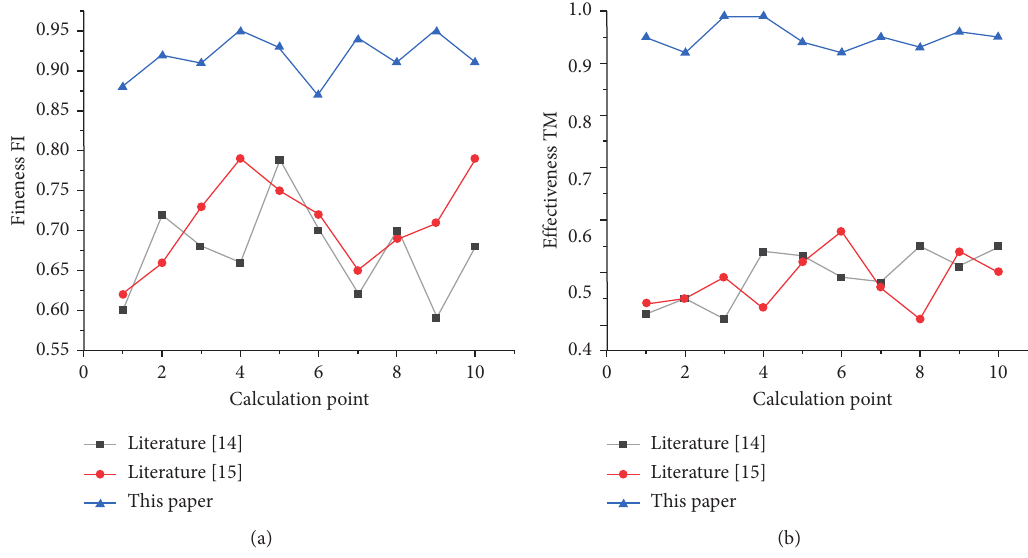
Figure 8: Traffic state recognition results of intersection. (a) Fineness comparison. (b) Effectiveness